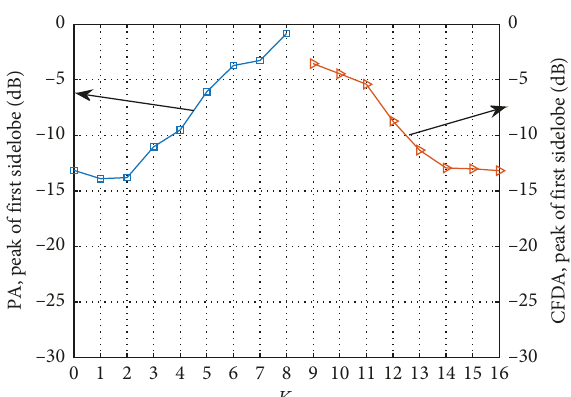
Figure 6: Peak of first sidelobe levels of the dominated PA and CFDA pattern, respectively, corresponds to K R